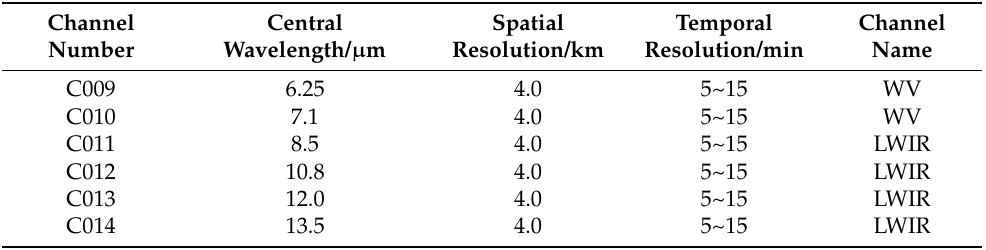
Table 1. The two WV (water vapor) and four LWIR (long-wave infrared) channel settings of the FY-4A AGRI.